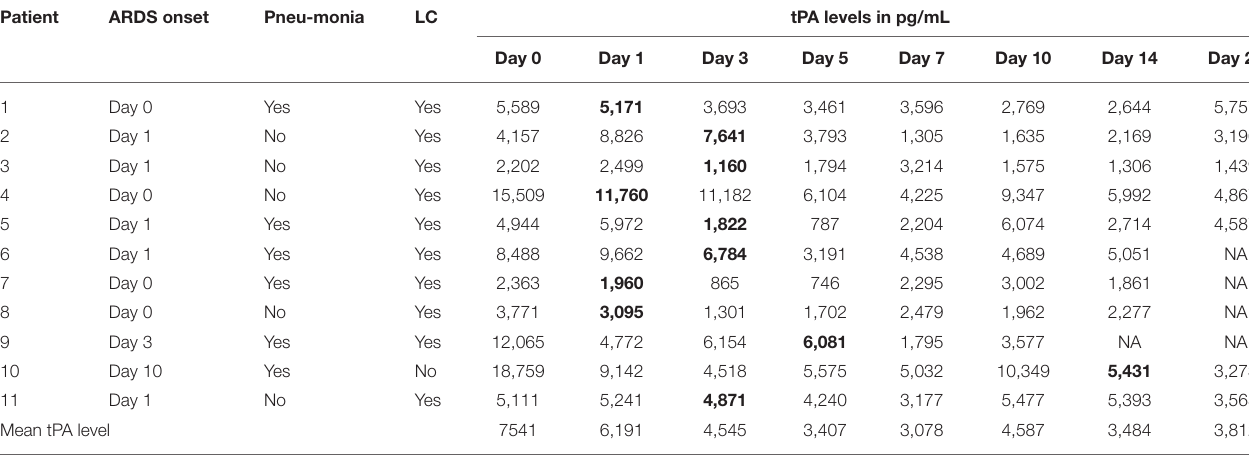
TABLE 3 | Individual levels of tPA antigen in each polytraumatized patient who developed ARDS. Patient